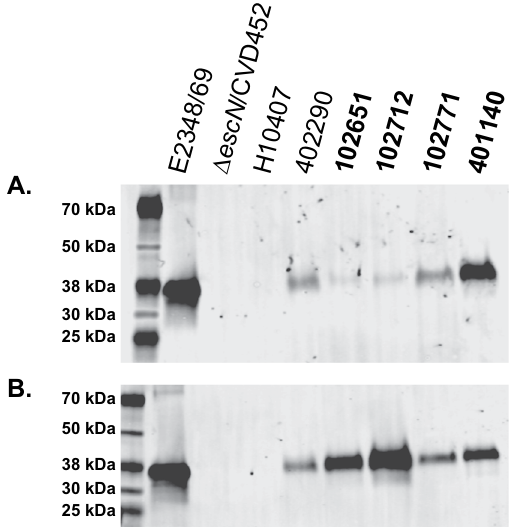
Figure 7. Functional characterization of T3SS in the EPEC/ETEC hybrid isolates. Immunoblot analysis for EspB in the supernatants of traditional EPEC (E2348/69 and 402290), ETEC (H10407), and the EPEC/ETEC hybrid isolates (102651, 102712, 102771, and 401140) grown in DMEM with high glucose ( A ) or with low glucose ( B ). Included as a negative control is E. coli CVD452, which is an isogenic T3SS-deficient ∆ escN mutant of E2348/69 49 and ETEC (H10407) which lacks a T3SS 28 . The first lane of each image contains the Chameleon Duo pre-stained protein ladder (Li-Cor). Under both conditions all of the EPEC/ETEC isolates have a functional T3SS as determined by the EspB secreted protein. The EPEC/ETEC isolates are indicated in